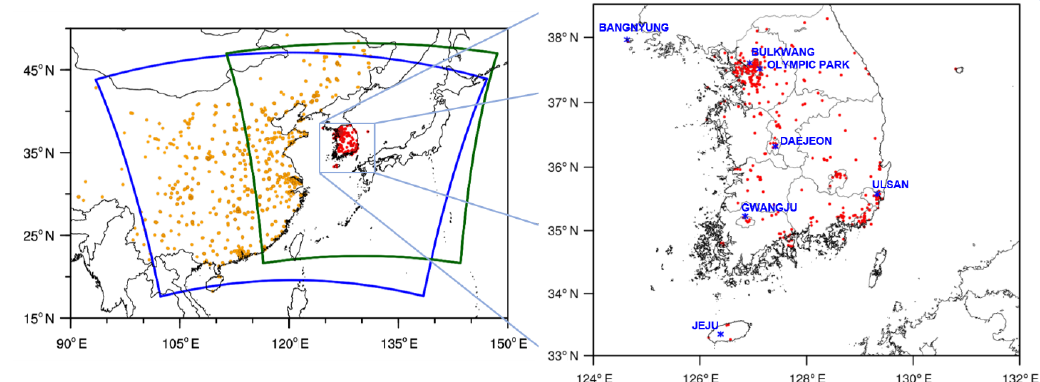
Figure 1. Domains of GOCI sensor (dark green line) and CMAQ model simulations (blue line). Red-colored dots denote the locations of Air Korea sites in South Korea. Orange-colored dots represent the locations of ground-based observation stations in China. Blue stars show the locations of seven supersites in South Korea. During the KORUS-AQ campaign, observation data were obtained from 1514 stations in China as well as 264 Air Korea and seven supersite stations in South Korea. NCL (2019) was used to draw this